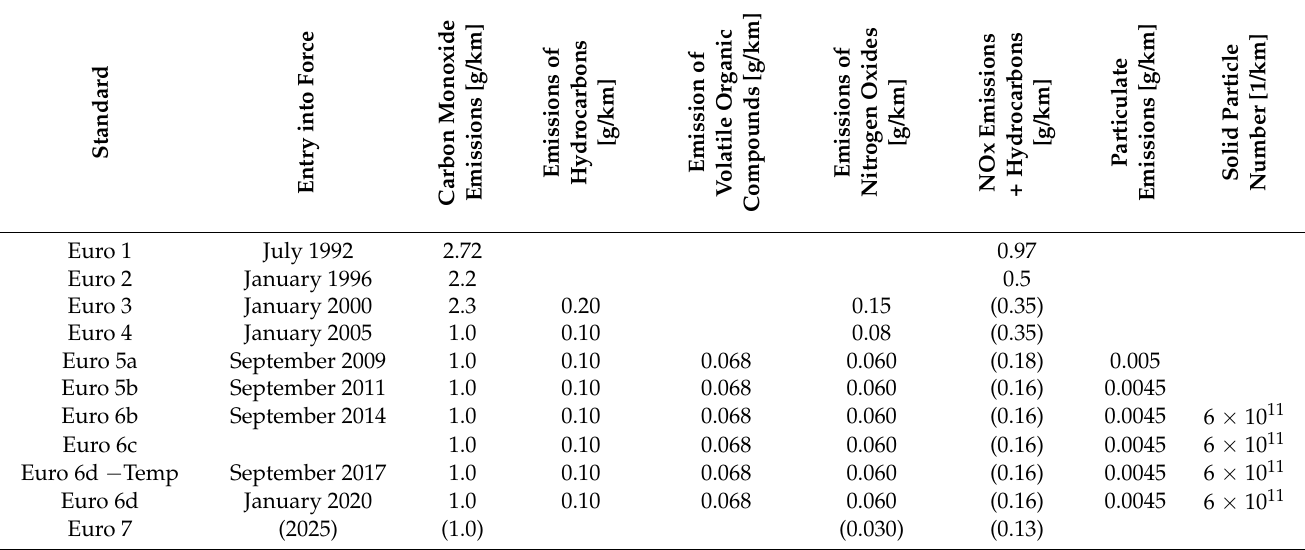
Table 1. List of Euro1–7